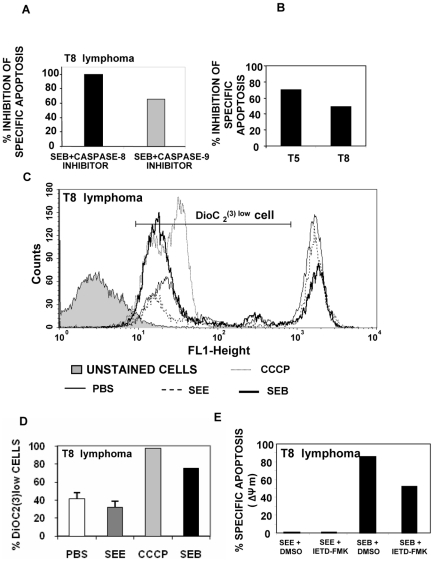
Mechanisms involved in Sag-induced apoptosis.A) Inhibition of Sag-induced apoptosis of lymphoma cells by caspase-8 and caspase-9 inhibitors. T8 cells (2.5×105) co-cultured with peritoneal macrophages (0.7×105) were treated during two hours with 25 µM of Z-IETD-FMK (caspase-8 inhibitor), Z-LEHD-FMK (caspase-9 inhibitor) or DMSO prior to the addition of 10 µg/ml of SEB or PBS. At day 3, cells were recovered, stained with Annexin/7-AAD and analyzed by FACS. The percentage of specific apoptosis was calculated as follows: 100× (% Sag induced apoptosis - % spontaneous apoptosis with PBS)/(100 - % spontaneous apoptosis with PBS). Inhibition of apoptosis by caspase inhibitors was calculated as reduction of specific apoptosis compared to specific apoptosis in the presence of DMSO set as 100%.(B) Inhibition of apoptosis by Fas-Fc fusion protein. T5 or T8 cells (2.5×105) co-cultured with peritoneal macrophages (0.7×105) were treated with SEI, SEB (10 µg/ml) or PBS. Ten µg/ml of Fas-Fc, HuIgG or PBS were added at day 2. At day 4, cells were harvested and stained with Annexin V-7AAD. Specific apoptosis was calculated as described in (A). Inhibition was calculated as reduction of apoptosis compared to apoptosis in the presence of HuIgG set as 100%. (C–D) Sags cause mitochondrial depolarization in cognate lymphoma T cells. T8 lymphoma cells (2.5×105) were cultured in the presence of 10 µg/ml of SEE, SEB or PBS as described in Material and Methods. Cells were harvested 72 hours after Sag exposure and the mitochondrial membrane potential (Δψm) was measured by FACS using DiOC2(3) staining. Representative overlayed histograms for DiOC2(3) fluorescence are depicted in (C).(D) Show the percentage of DiOC2(3)low cells. Data are expressed as the mean ± SD. *p<0.05. (E) Caspase-8 inhibitor decreases the loss of Δψm induced by SEB. T8 lymphoma cells (0.25×106) were incubated with 25 µM Z-IETD-FMK or DMSO for 2 hours before exposure to 10 µg/ml of SEE, SEB or PBS. Cells were harvested 72 hours later and Δψm was measured by FACS using DiOC2(3) staining. Apoptotic cells were identified by their decrease in Δψm (DiOC2(3)low). Data show the percentage of specific apoptosis calculated as described in (A). All the experiments were performed at least three times with similar results.